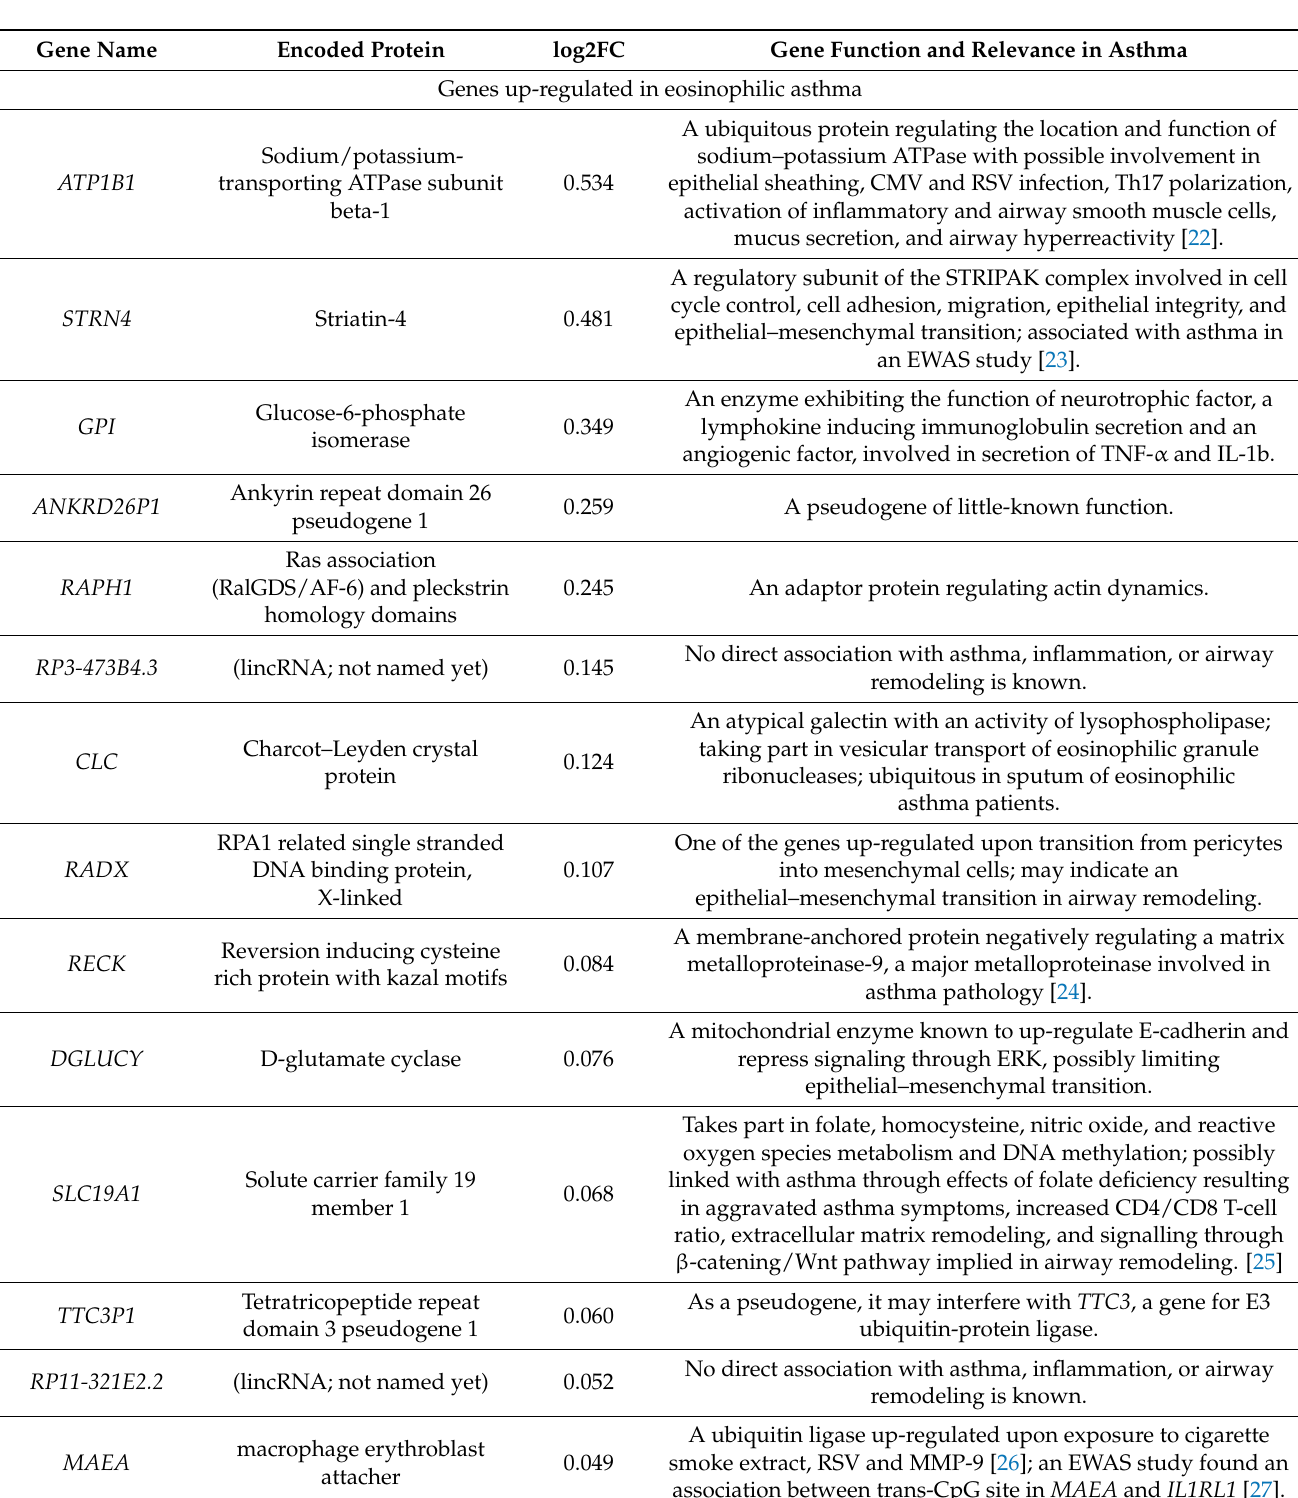
Table 6. Differentially co-expressed genes in bronchial brush biopsy samples of eosinophilic and non-eosinophilic asthma patients. Data obtained from UniProtKB/Swiss-Prot database [15], unless stated